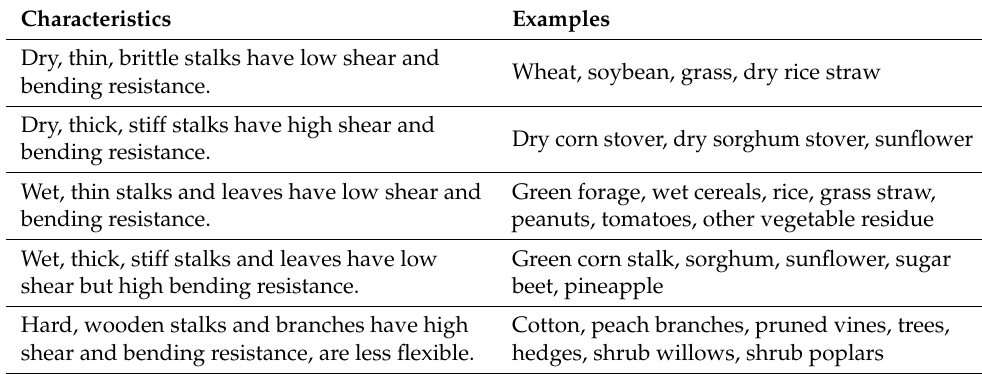
Table 1. Crop classifications are based on physical characteristics for handling and processing [34]. Characteristics Examples Dry, thin, brittle stalks have low shear and bending resistance. Dry, thick, stiff stalks have high shear and bending resistance. Wet, thin stalks and leaves have low shear and bending resistance. Wet, thick, stiff stalks and leaves have low Hard, wooden stalks and branches have